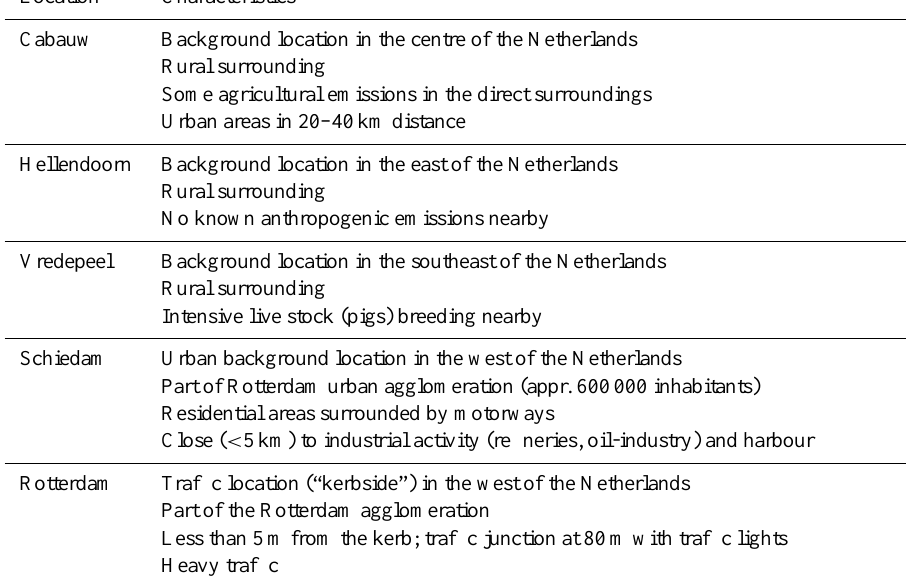
Table 1. Properties of the measurement locations.